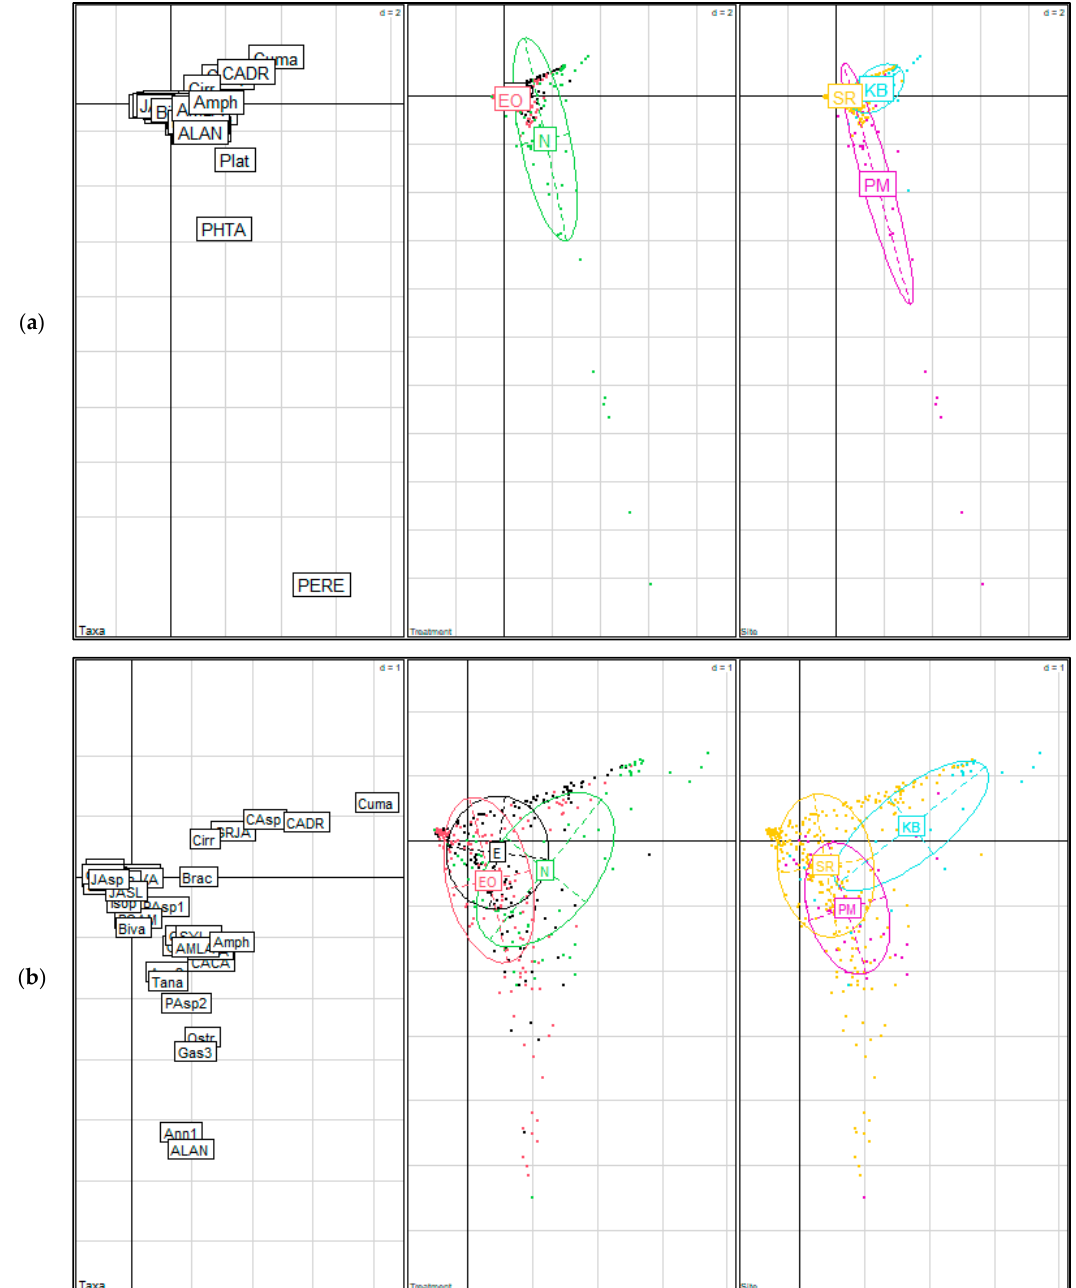
Figure 4. Correspondence analysis of taxa detected from shoot samples from restored eelgrass within eelgrass only (E)